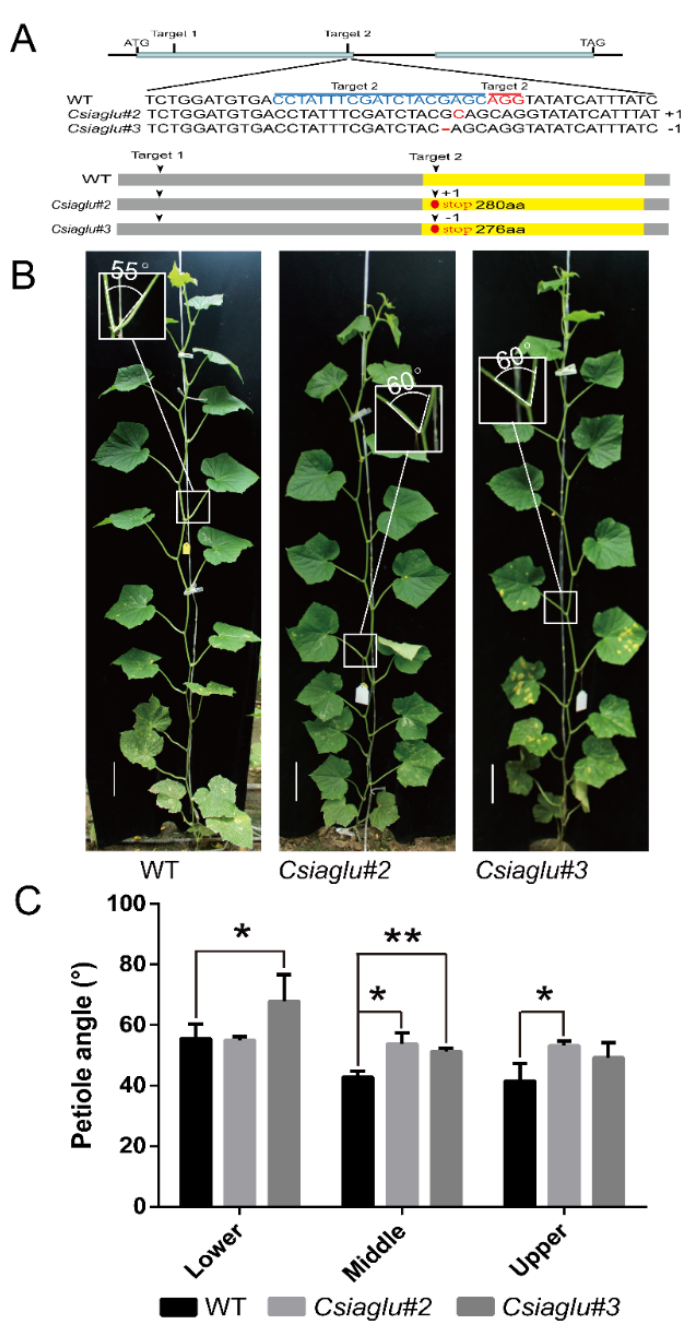
Figure 3. Phenotypic characterization of WT and Csiaglu mutant plants: ( A ) Identification of Csiaglu mutants. Two targets were selected at the first exon of CsIAGLU ; the sgRNA targets are marked in blue, and protospacer-adjacent motif (PAM) sites are highlighted in red. The genotype analysis indicated that the Csiaglu#2 allele inserted 1 bp at the second target and the Csiaglu#3 allele deleted 1 bp at the second target. The red dots represent the termination codon, and the yellow boxes indicate the UDPGT domain. ( B ) Representative images of WT and Csiaglu mutant plants. The white boxes indicate the LPA of the largest leaf. Scale bars represent 10 cm. ( C ) Statistical analysis of LPAs of WT and Csiaglu mutants. Values are means of LPAs from the same part of 3 independent plants. A significance analysis was conducted with the two-tailed Student’s t -test (* p < 0.05 and ** p < 0.01). Values are means ± SDs.